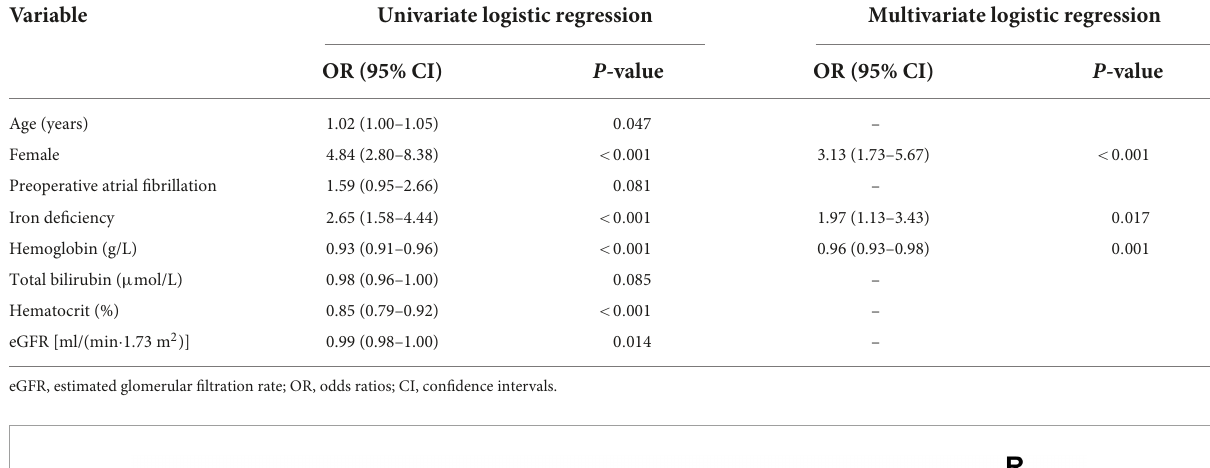
TABLE 2 Multiple logistic regression for intraoperative RBC transfusion.